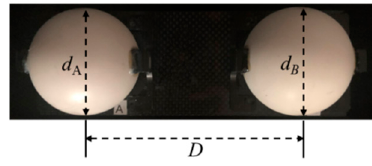
Figure 5. A dumbbell gauge. The sphere diameter d A = 50.7784 mm, d B = 50.7856 mm and sphere center distance D